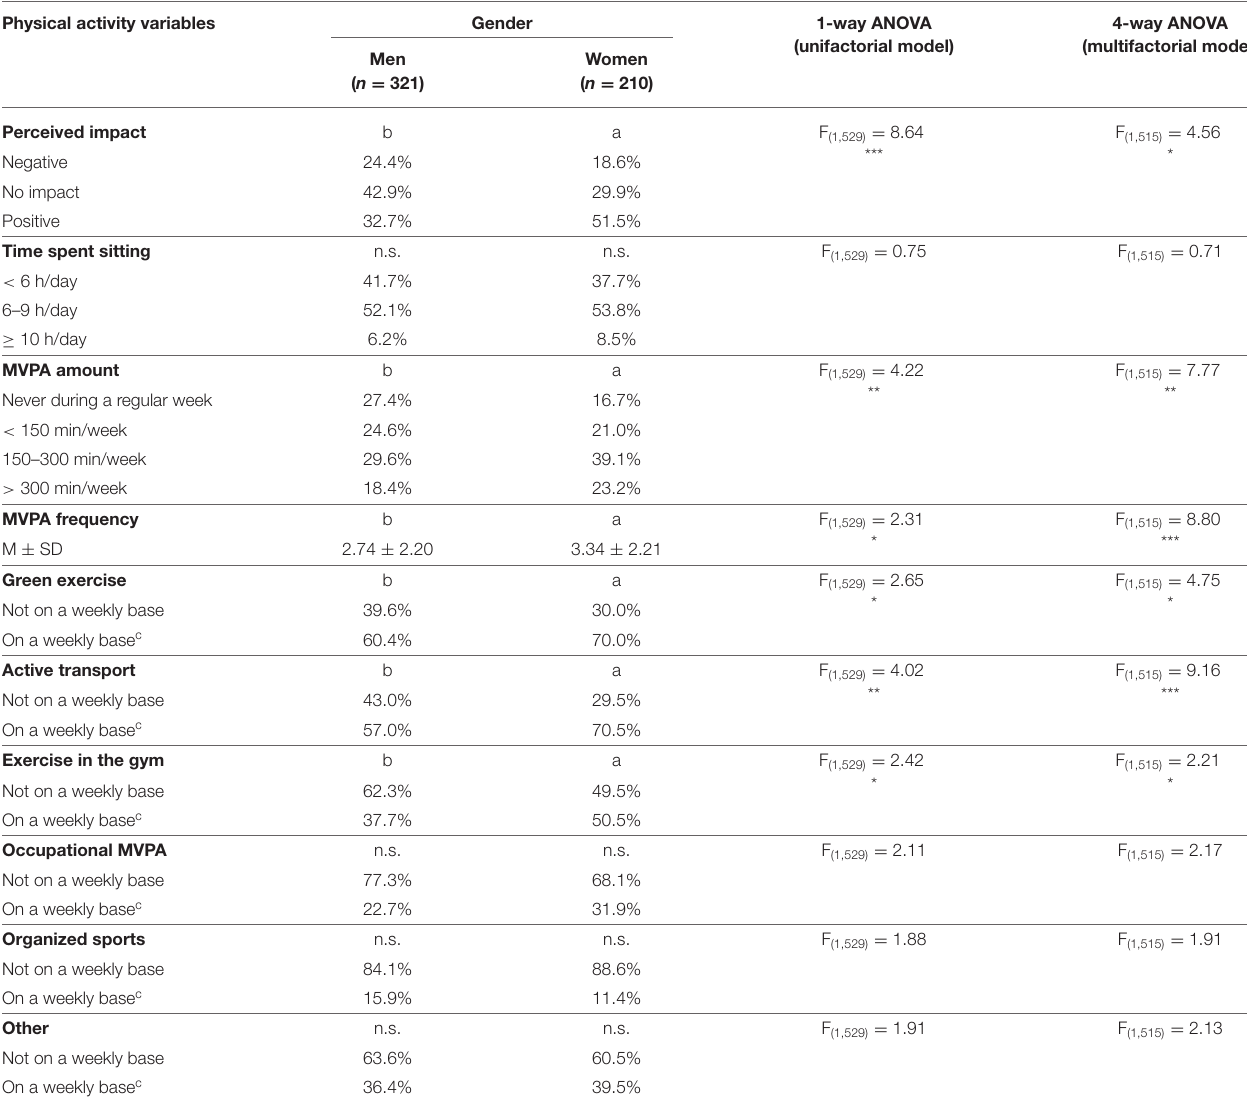
TABLE 3 | Physical activity profile of Italian immigrants in Norway, by gender ( n = 531). Physical activity